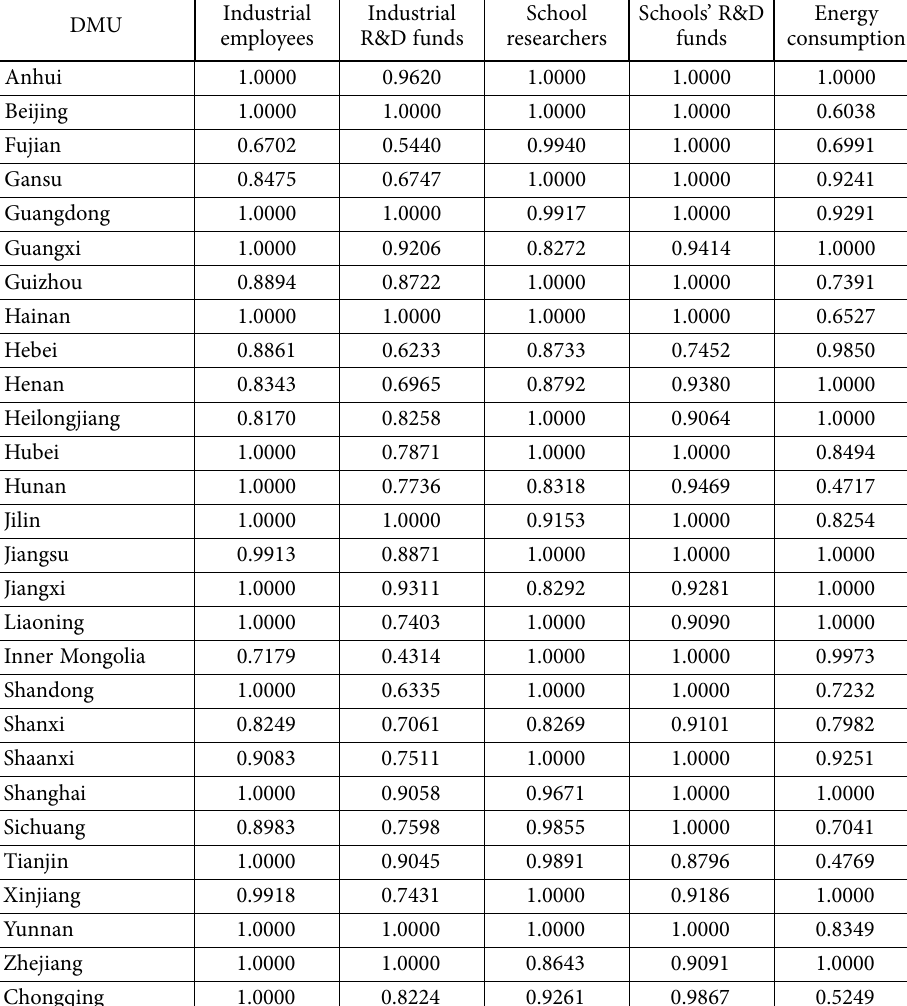
Table 8. Average input efficiency by